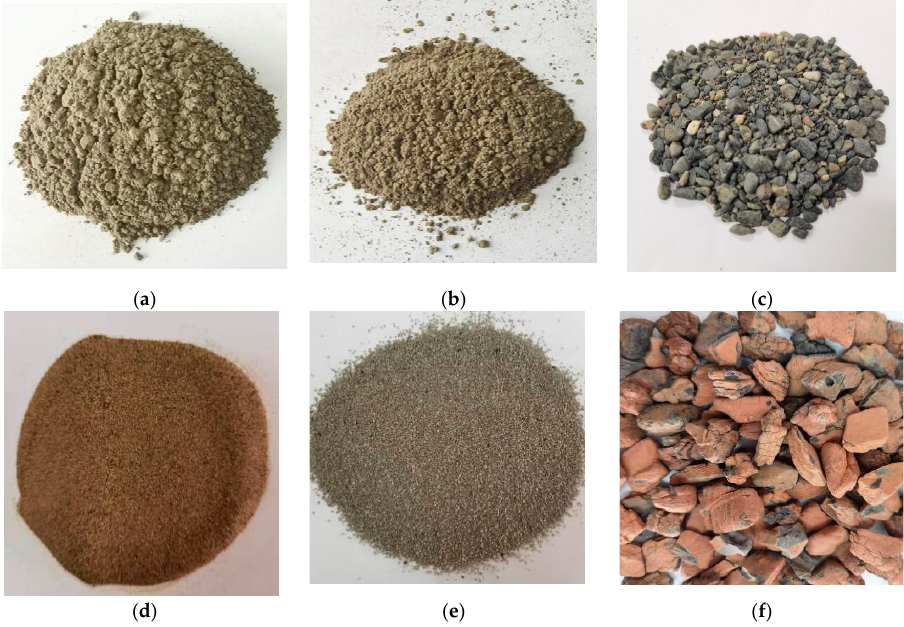
Figure 1. The raw materials: ( a ) cement; ( b ) fly ash; ( c ) RS; ( d ) DS; ( e ) FACs; ( f ) shale ceramsite.